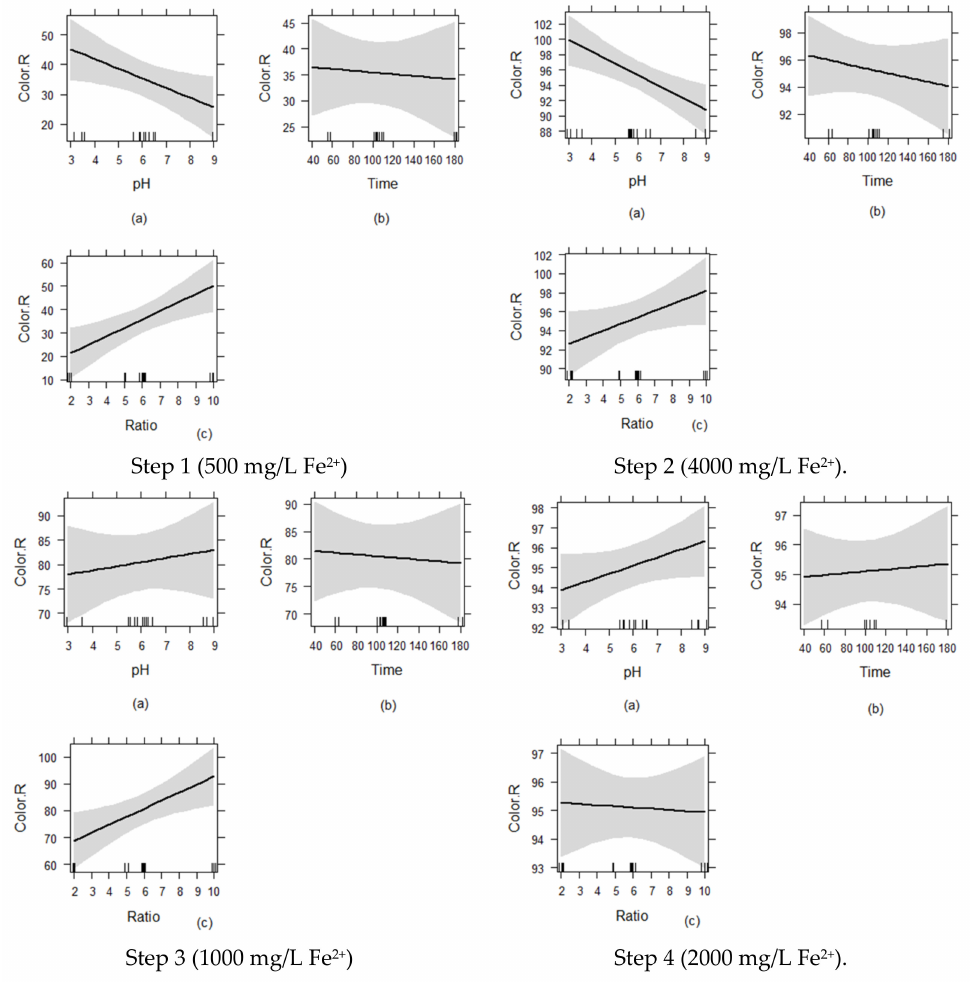
Figure 1. Effect plots of the independent variables on color removal for ( a ) pH, ( b ) time, ( c ) H 2 O 2 :Fe 2+ ratio. Table 5. Coded variable of central composite experiments